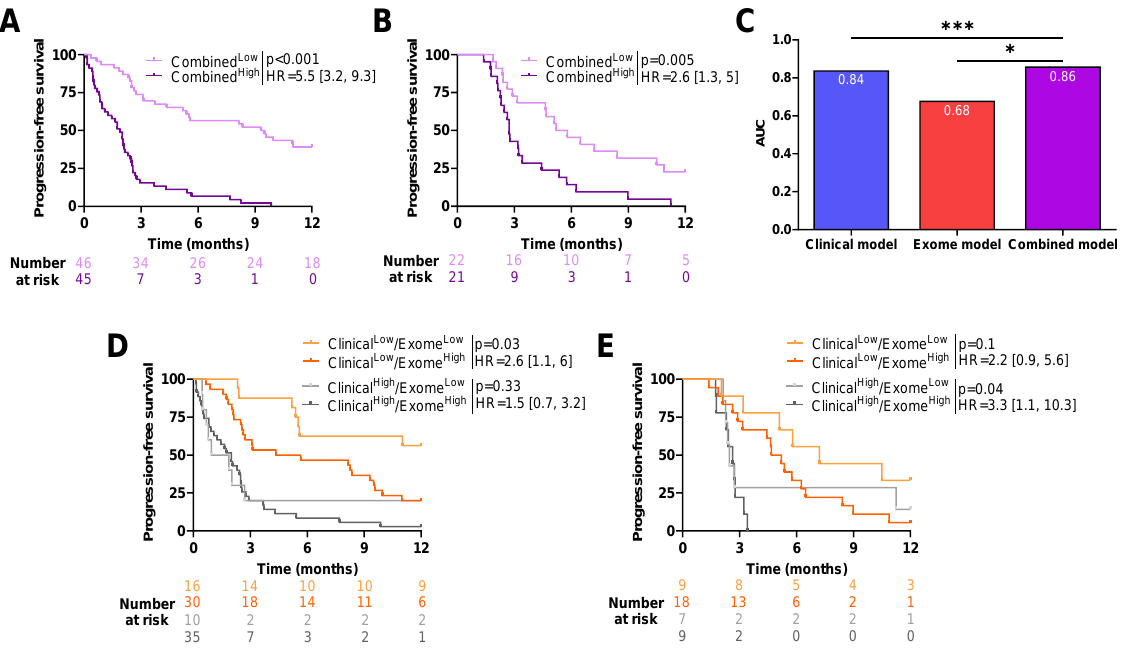
Figure 5. Association between progression-free survival and clinical and exome-derived variables. Kaplan–Meier curves with patients stratified according to dichotomized linear predictors obtained from the combined model for progression-free survival in ( A ) training cohort and ( B ) validation cohort. Kaplan-Meier curves with patients stratified according to clinical and exome models for progression-free survival for the (D) training cohort and (E) validation cohort. ( C ) Barplots of time-dependent AUC (Area Under the Curve) for clinical, exome, and combined (clinical and exome) models for progression-free survival. * p < 0.05, *** p < 0.001.